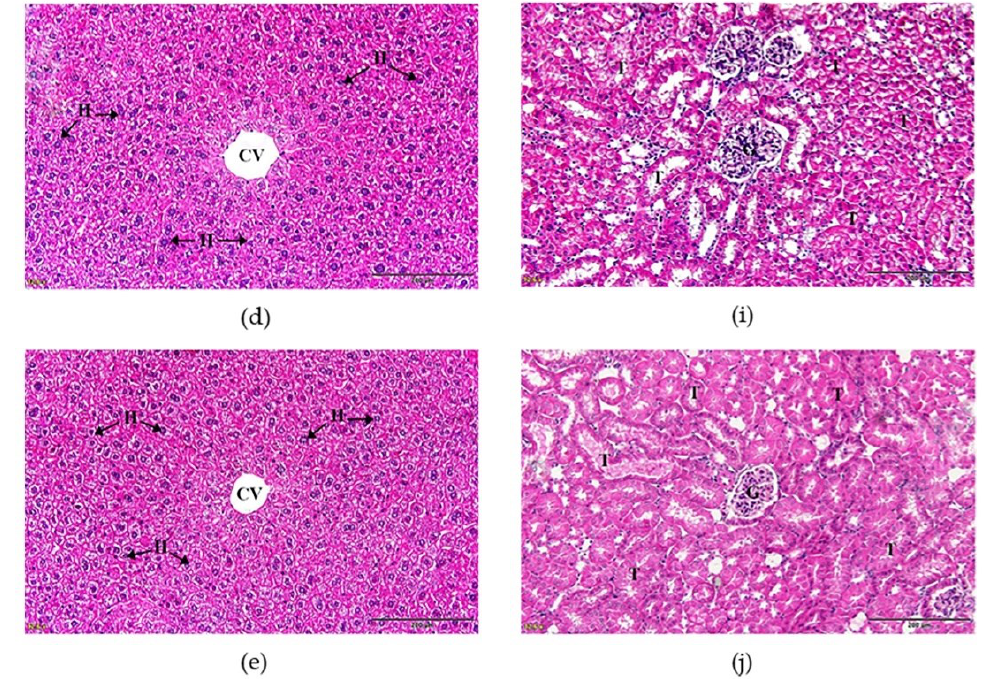
Figure 4. Histopathological examination of liver and kidney tissues from ICR mice that administrated with ethanolic extract from M. fragrans , A. lancea , and Prabchompoothaweep remedy in acute toxicity test: ( a ) histology of the liver tissue of control group, ( b ) histology of the liver tissue of 7% Tween 80 group, ( c ) histology of the liver tissue of M. fragrans treated mice, ( d ) histology of the liver tissue of A. lancea treated mice, ( e ) histology of the liver tissue of Prabchompoothaweep remedy treated mice, ( f ) histology of the kidney tissue of control group, ( g ) histology of the kidney tissue of 7% Tween 80 group, ( h ) histology of the kidney tissue of M. fragrans treated mice, ( i ) histology of the kidney tissue of A. lancea treated mice, ( j ) histology of the kidney tissue of Prabchompoothaweep remedy treated mice. All images were acquired at 20 × magnification. Bar = 200 µ m. CV, central vein; H, hepatocyte; T, tubule; G,